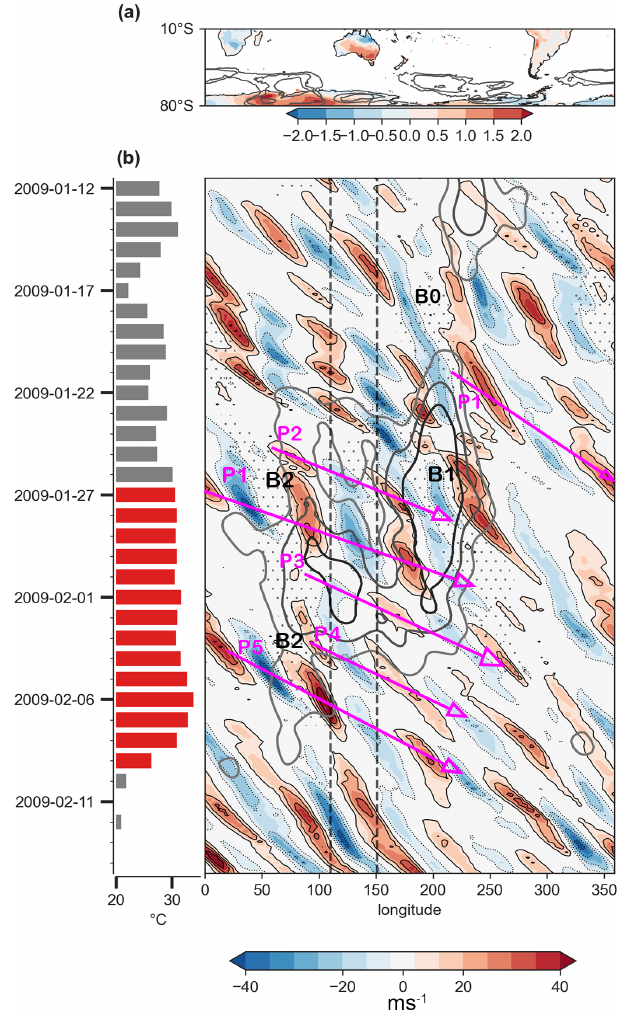
Figure 6. Same as in Fig. 4 but for the February 2009 SEA heat-